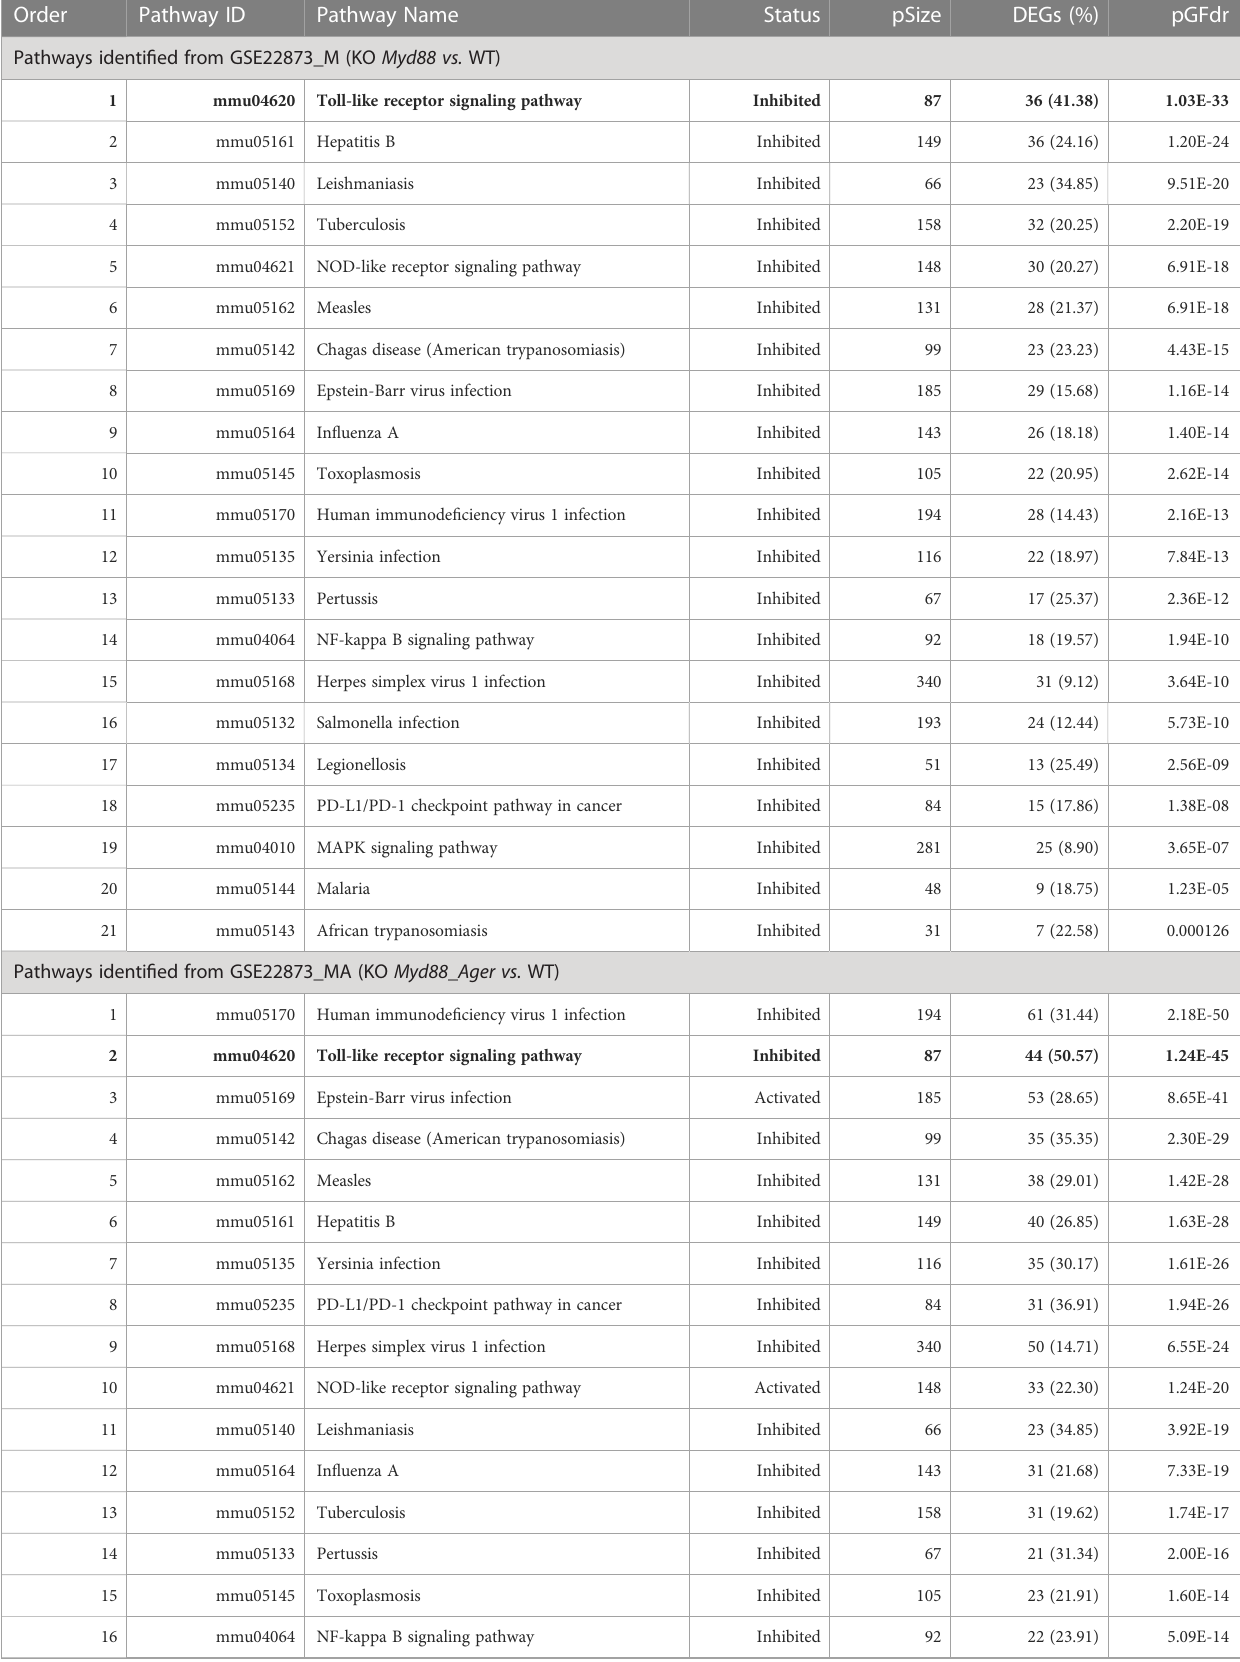
Table 2 True KO signaling pathways identi fi ed by SPIA from GSE22873. Order Pathway ID Pathway Name Status pSize DEGs (%)